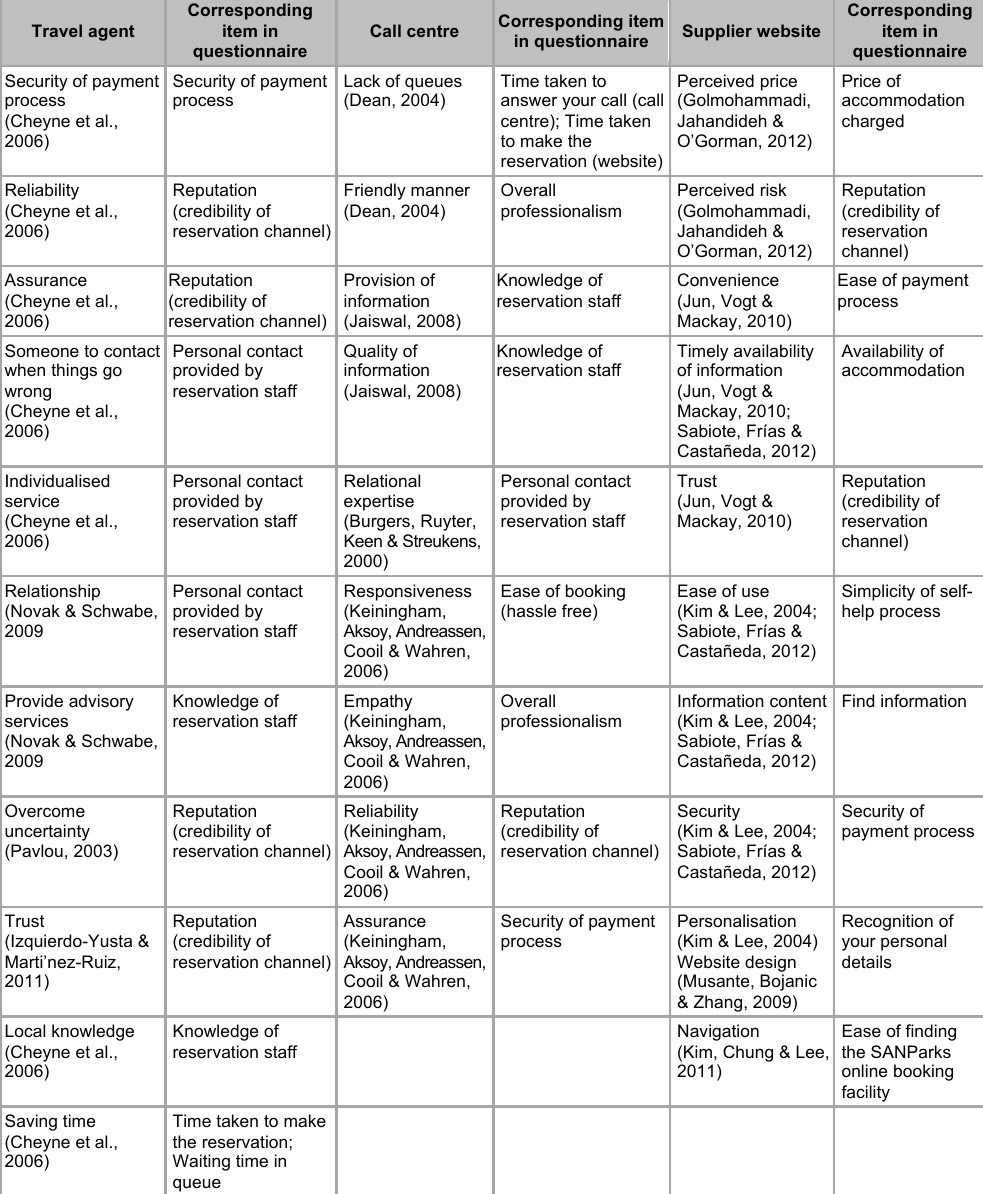
Customer requirements used when measuring the performance of distribution